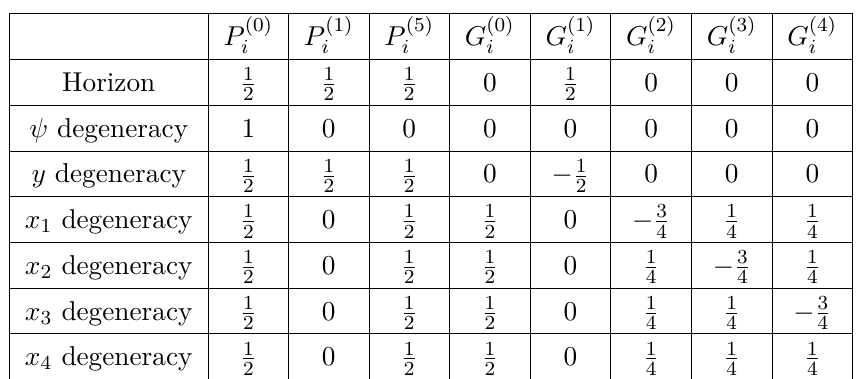
Table 4 . The seven possible weights at the i th rod leading to a regular coordinate degeneracy of the timelike direction or a compact spacelike